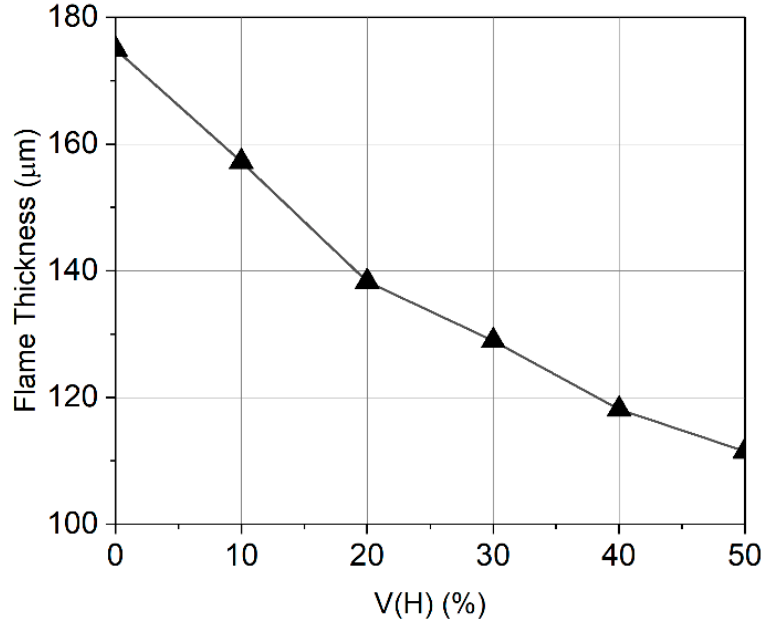
Figure 14. Flame thickness, depending on the volume fraction of hydrogen in the mixture [31].